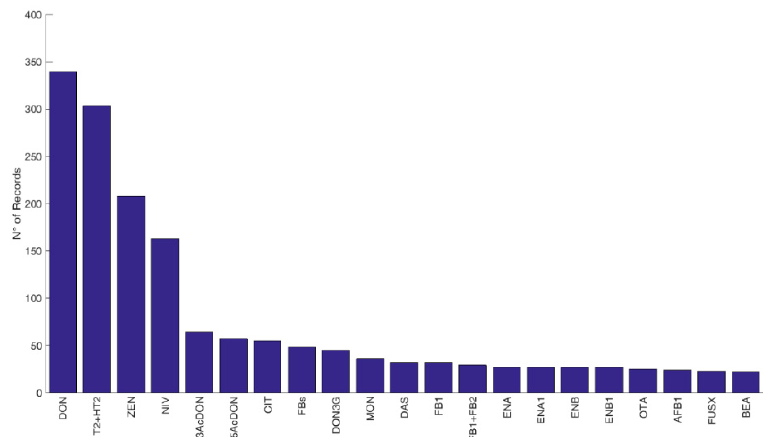
Figure 4. Frequency of reported mycotoxins and secondary metabolites in cereals without specifications